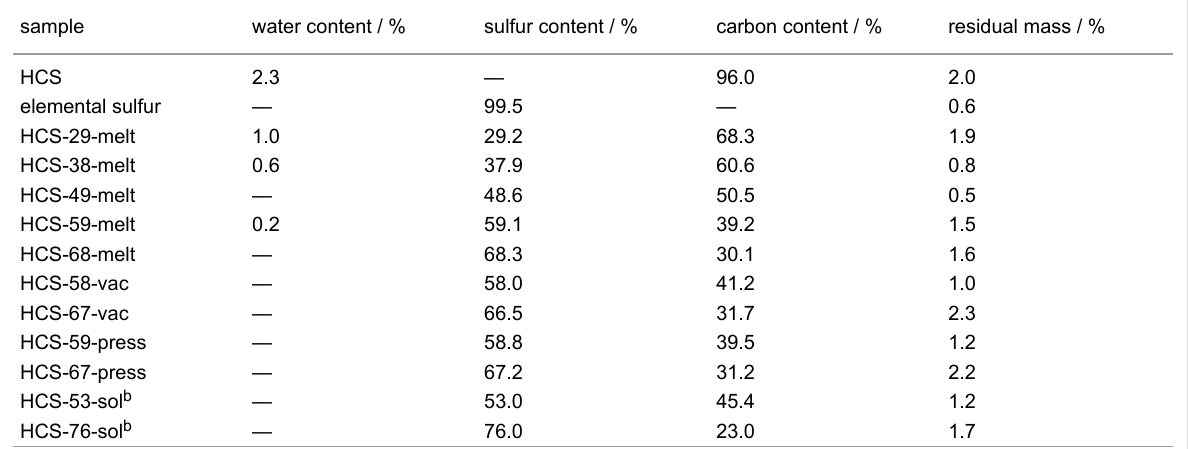
Table 1: Water, sulfur and carbon content of HCS, HCS/sulfur composites and elemental sulfur determined by thermogravimetric measurements as well as the residual mass after thermogravimetry. a